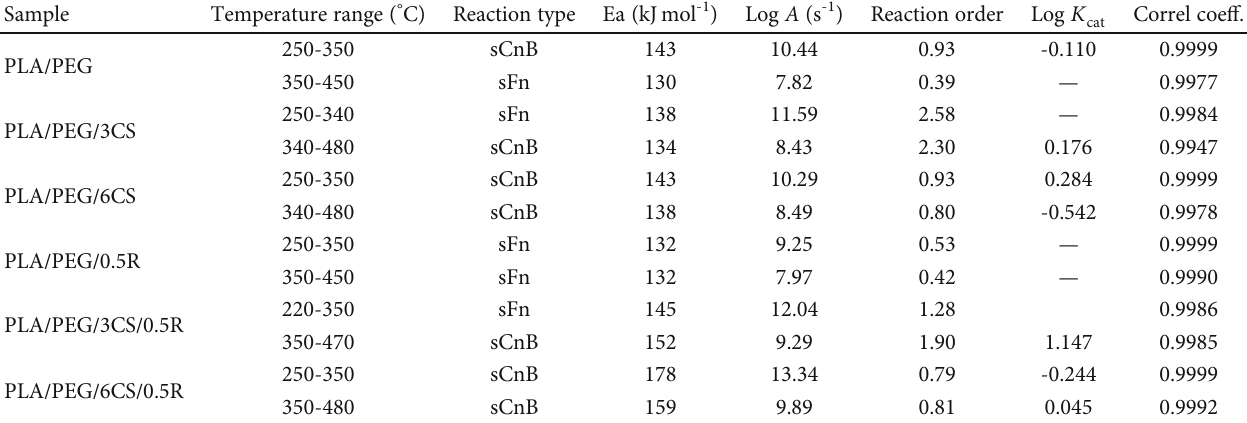
Table 4: Kinetic parameters obtained by the multiple linear regression (MLR) method.